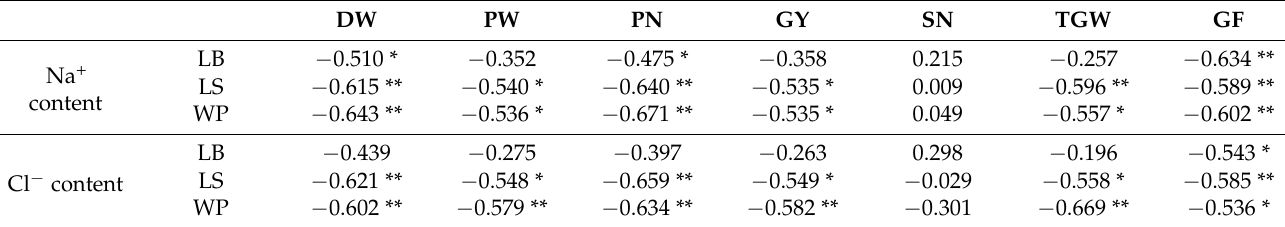
Table 2. Pearson correlation coefficients between ion contents and grain yield and yield-related traits of Koshihikari and selected CSSLs under salinity in 2015. Values are mean ± standard error (n = 4). * and ** indicate significant differences at the 5% and 1% levels,